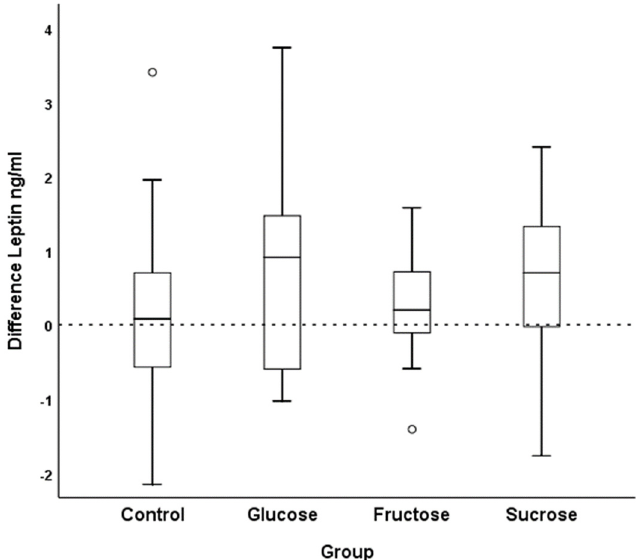
Figure 3. Difference in leptin concentrations between post-SSB intervention values or SSB abstinence values (control) (week 7), respectively, and baseline values (week 0) (boxplot with medians).